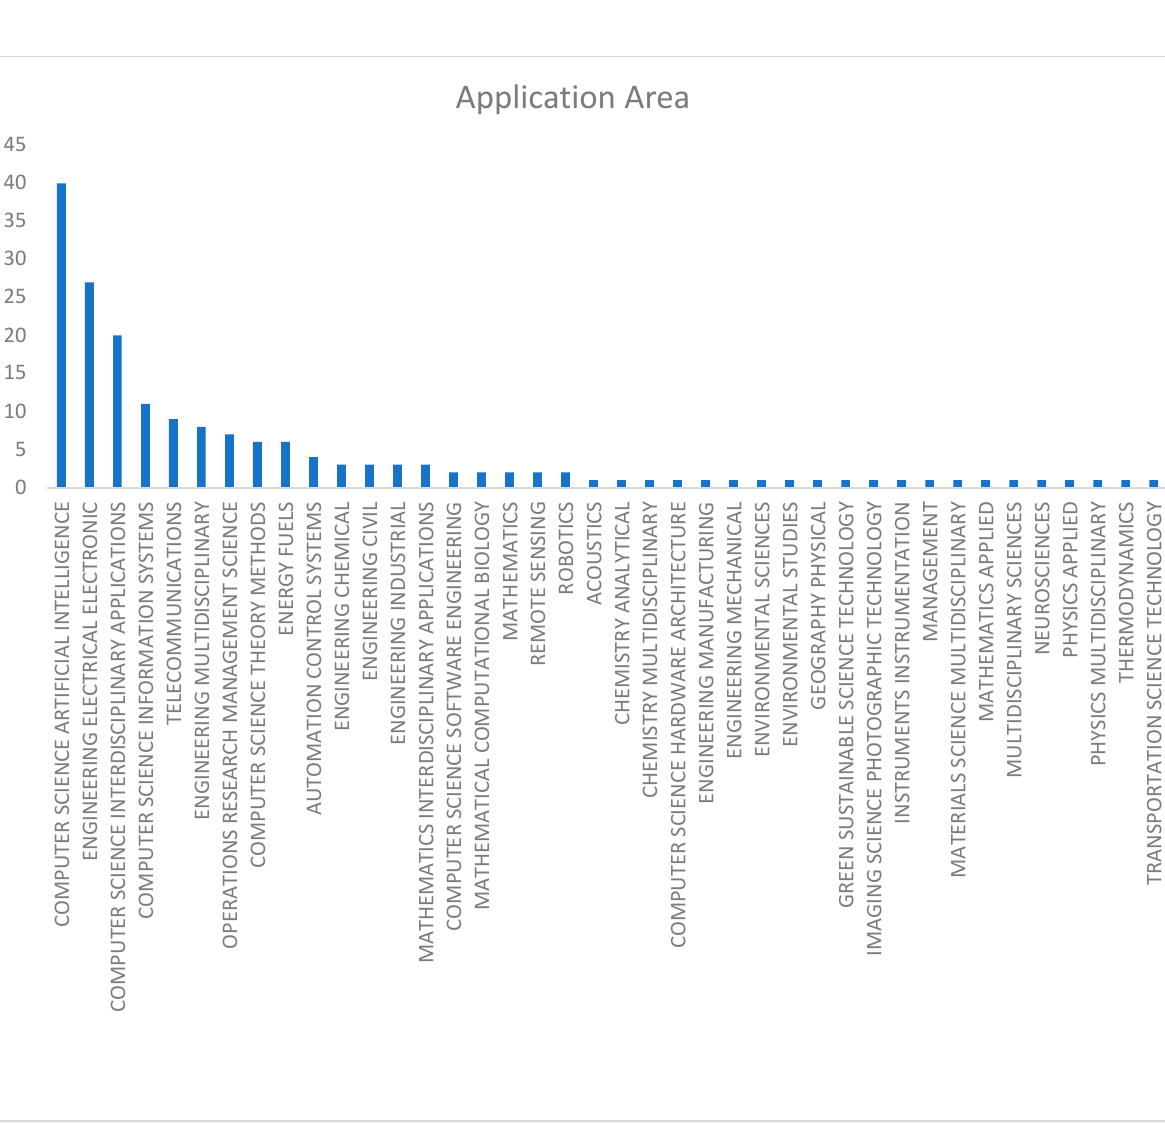
Figure 10. Application areas reported in the literature.